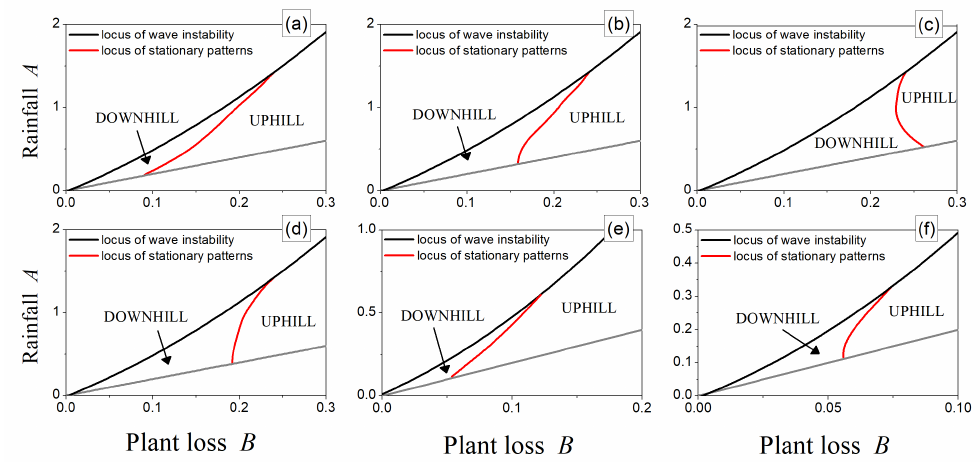
Figure 6. Loci of wave instability (black lines) and null-migration patterns (red lines) for ( a ) τ = 10 − 5 , ( b ) τ = 10 − 3 , ( c ) τ = 10 − 2 , ( d ) τ = 1, ( e ) τ = 10, and ( f ) τ = 10 2 . Fixed parameter: ψ =